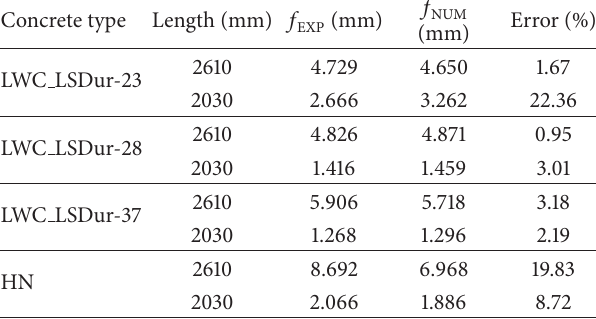
Table 7: Plasticity + chemical bond model. Comparison of errors (%) between numerical and experimental results at the shear-bond failure